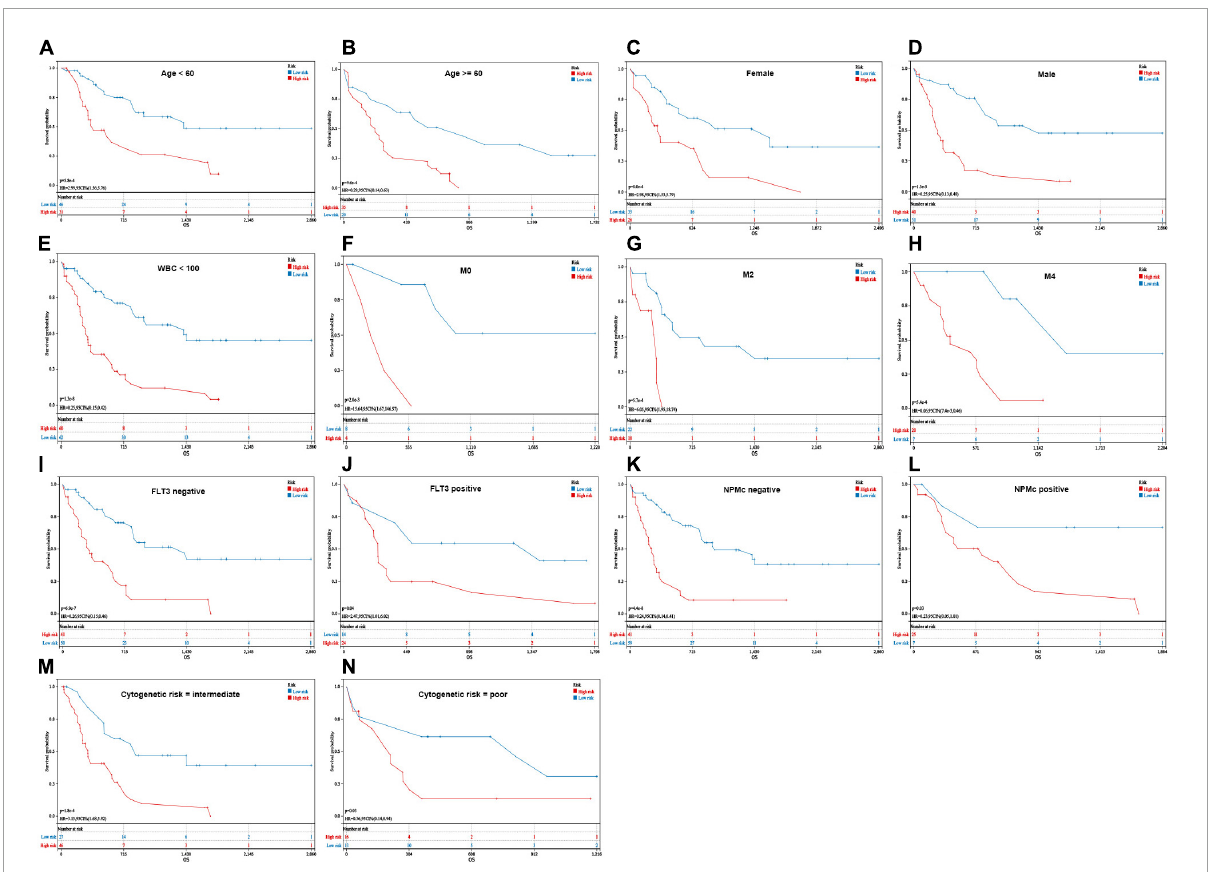
FIGURE5 Kaplan–Meier analysis of OS in different groups. (A,B) Age ( < 60 years and ≥ 60 years). (C,D) Sex (female and male). (E) WBC counts ( < 100 × 10 9 /L). (F–H) French-American-British (FAB) classification (M0, M2, and M4). (I,J) FLT3 mutation (positive and negative). (K,L) NPMc mutation (positive and negative). (M,N) Cytogenetic risk (intermediate and